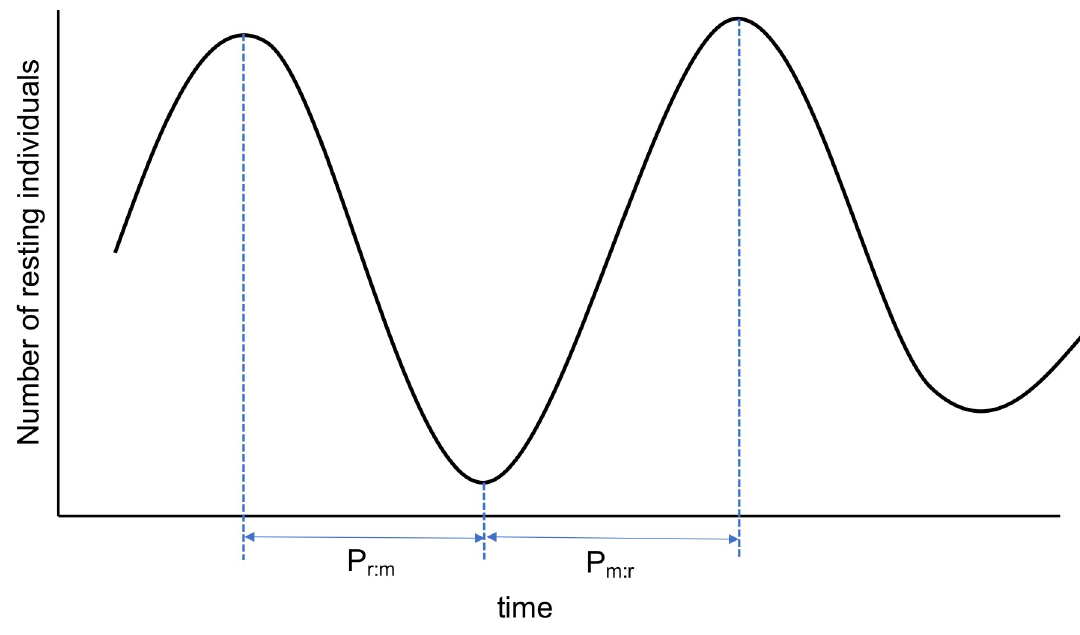
Fig 4. The explanation of P m:r and P r:m